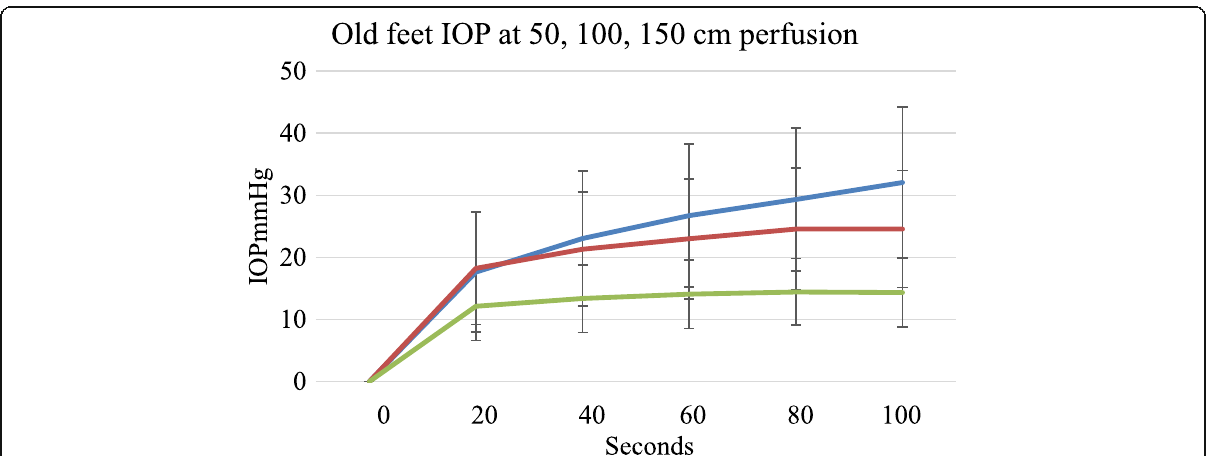
Fig. 6 Older feet had a different filling curve profile with continued perfusion. They become increasingly oedematous with no obvious IOP end point.